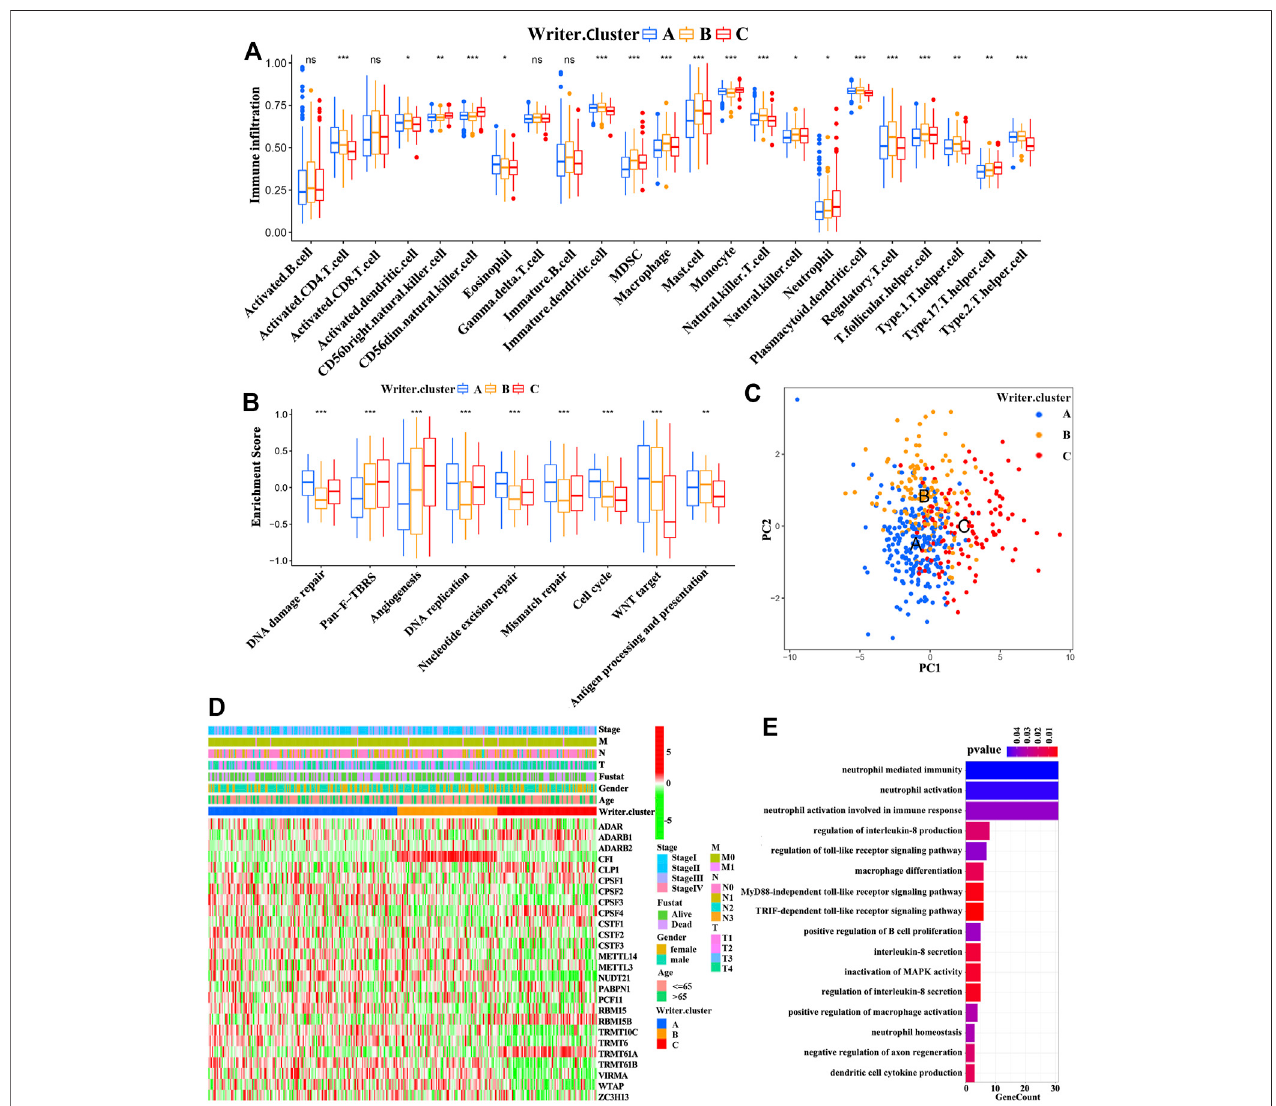
FIGURE 3 | TME and transcriptome characteristics in distinct RNA modi fi cation patterns. (A) Evaluating the abundance of each tumor-in fi ltrating immune cell in three writer clusters using ssGSEA. (* p < 0.05; ** p < 0.01; *** p < 0.001). (B) Differences in immune-associated pathways among three writer clusters (ANOVA analysis; * p < 0.05; ** p < 0.01; *** p < 0.001). (C) Principal component analysis for the transcriptome pro fi les of patients in different writer clusters. (D) The association between RNA modi fi cation patterns (based on writer clusters) and clinical parameters, including age, gender, clinical stage, T-stage, N-stage, M-stage and survival status. (E) Functional annotation for differentially expressed genes (DEGs) (GO enrichment analysis, biological progress; BP).